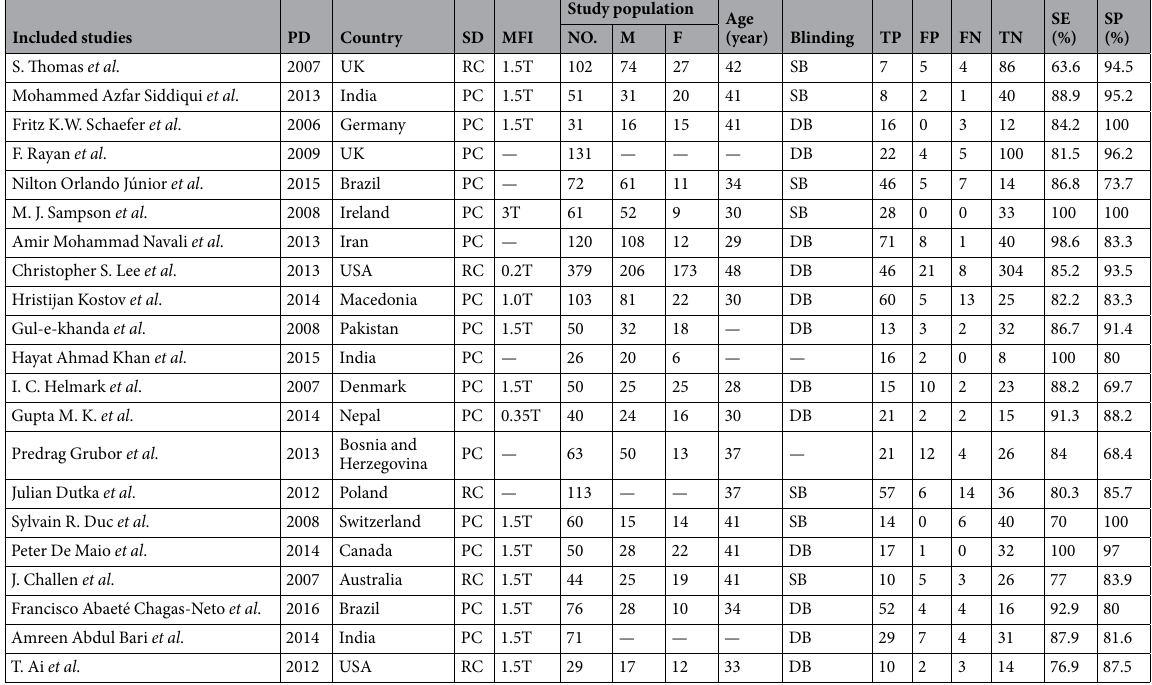
Table 1. Basic characteristics of the studies included in the meta-analysis. PD: publication date; SD: study design; RC: retrospective cohort; PC: prospective cohort; MFI: magnetic field intensity; No.: number; M: male;